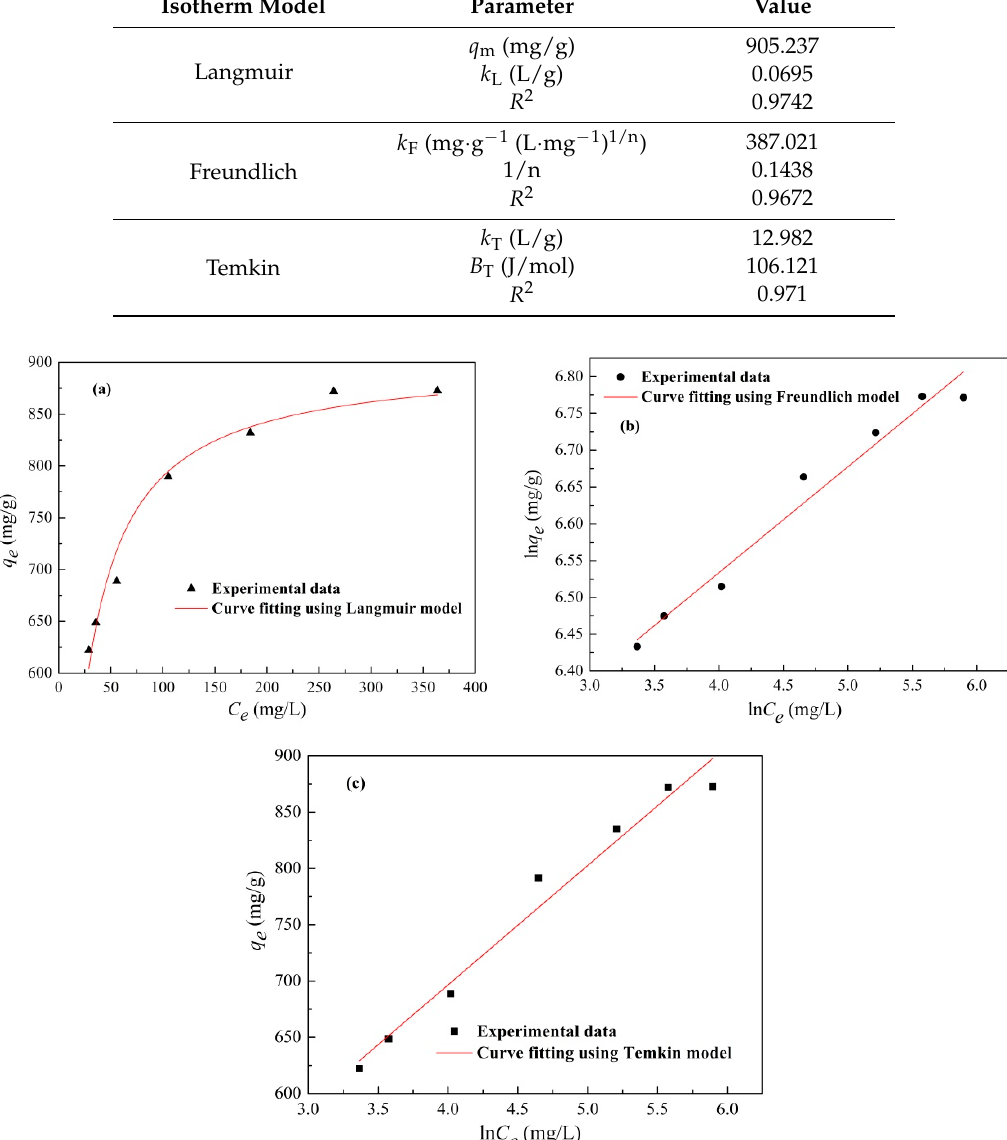
Figure 6. Adsorption isotherms of Ag + on TSC-CC resin, ( a ) Langmuir model; ( b ) Freundlich model; ( c ) Temkin model. ( c ) Temkin